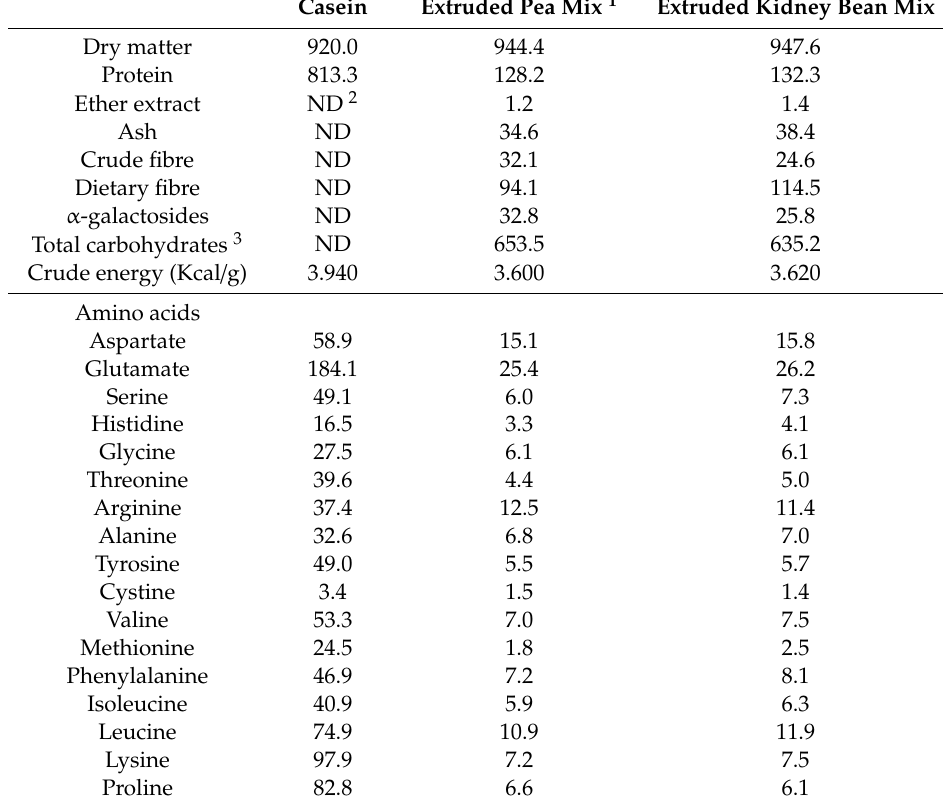
Table 1. Analysed composition (g / kg) of casein and the legume + cereal extruded